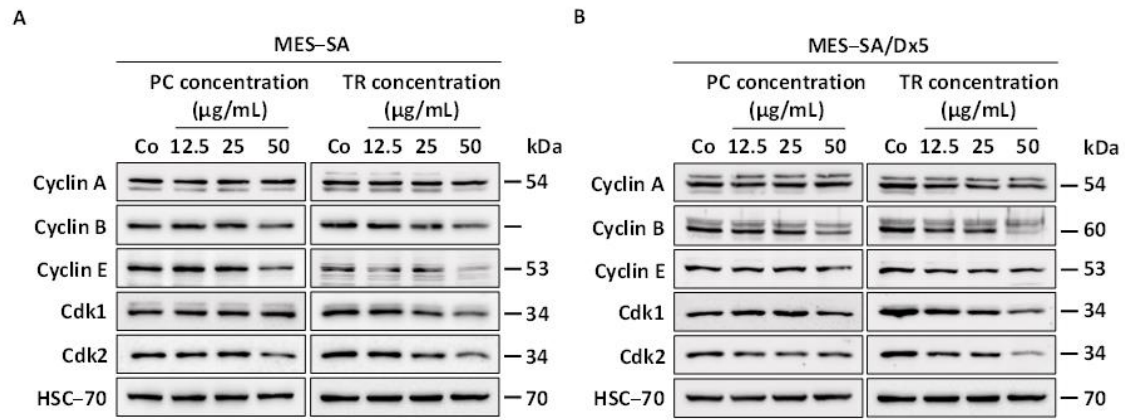
Figure 5. Modulation of key cell cycle regulators by Pituranthos chloranthus (PC) and Teucrium ramosissimum Desf. (TR) extracts in MES-SA and MES-SA/Dx5 cell lines. ( A , B ) Immunoblot analysis of cyclin A, B, E, Cyclin-dependent kinase 1 (Cdk1), and Cyclin-dependent kinase 2 (Cdk2) after a 72 h incubation period with vehicle (dimethyl sulfoxide, DMSO; Control, Co) or 12.5, 25, and 50 µg/mL of PC and TR in MES-SA ( A ) and MES-SA/Dx5 ( B ) cells. Heat shock cognate 70 (HSC-70) was used as the loading control. A representative blot from three independent experiments is shown.